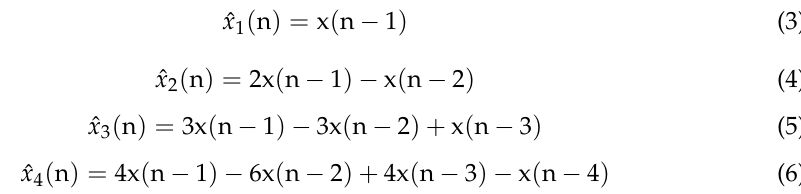
Figure 3. The ECG signal, prediction errors for linear prediction orders 1, 2, 3, and 4, and the deter- mined prediction error of MITDB record number ”100”. To convert the amplitude to millivolts, di- vide the value by 200. The non-negative prediction error is then encoded into the quotient and remainder by using the power k(n) of 2 in Equations (9) and (10), q(n) = M(n) 2 () ⁄